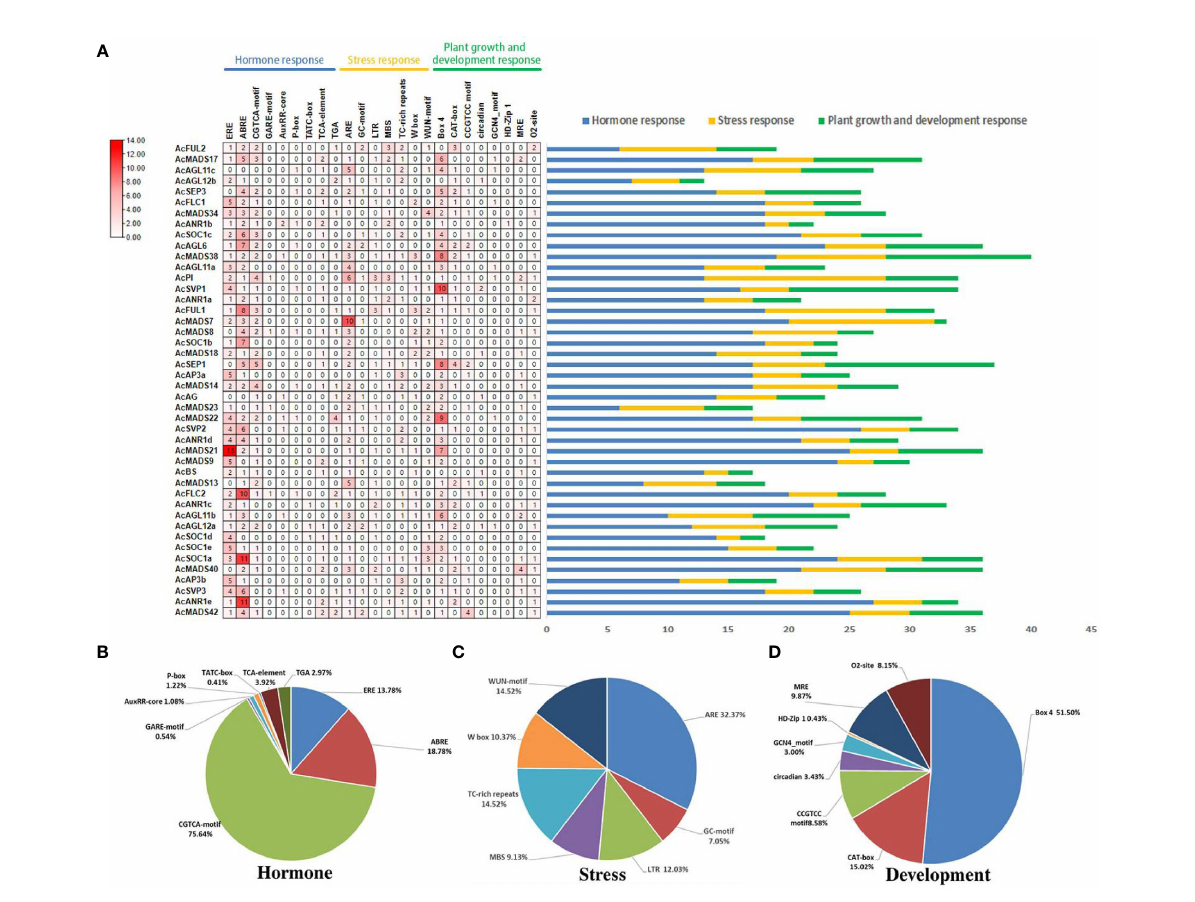
FIGURE 6 Organization of cis -acting regulatory elements of AcMADS genes in pineapple. (A) The number of cis -acting elements of AcMADS genes. (B) The total amount of each cis -acting elements as a percentage of hormone-responsive elements. (C) The total amount of each cis -acting elements as a percentage of stresses-related elements. (D) The total amount of each cis -acting elements as a percentage of the cis-acting element involved in plant development and